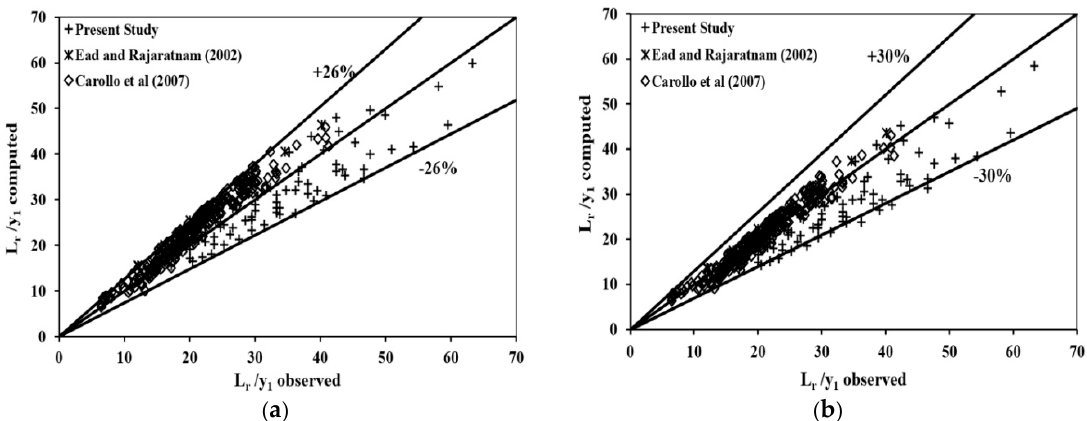
Figure 17. Comparison between the experimental values of the ratio L r / y 1 and ( a ) values computed by Equation (31), ( b ) values computed by Equation (32).